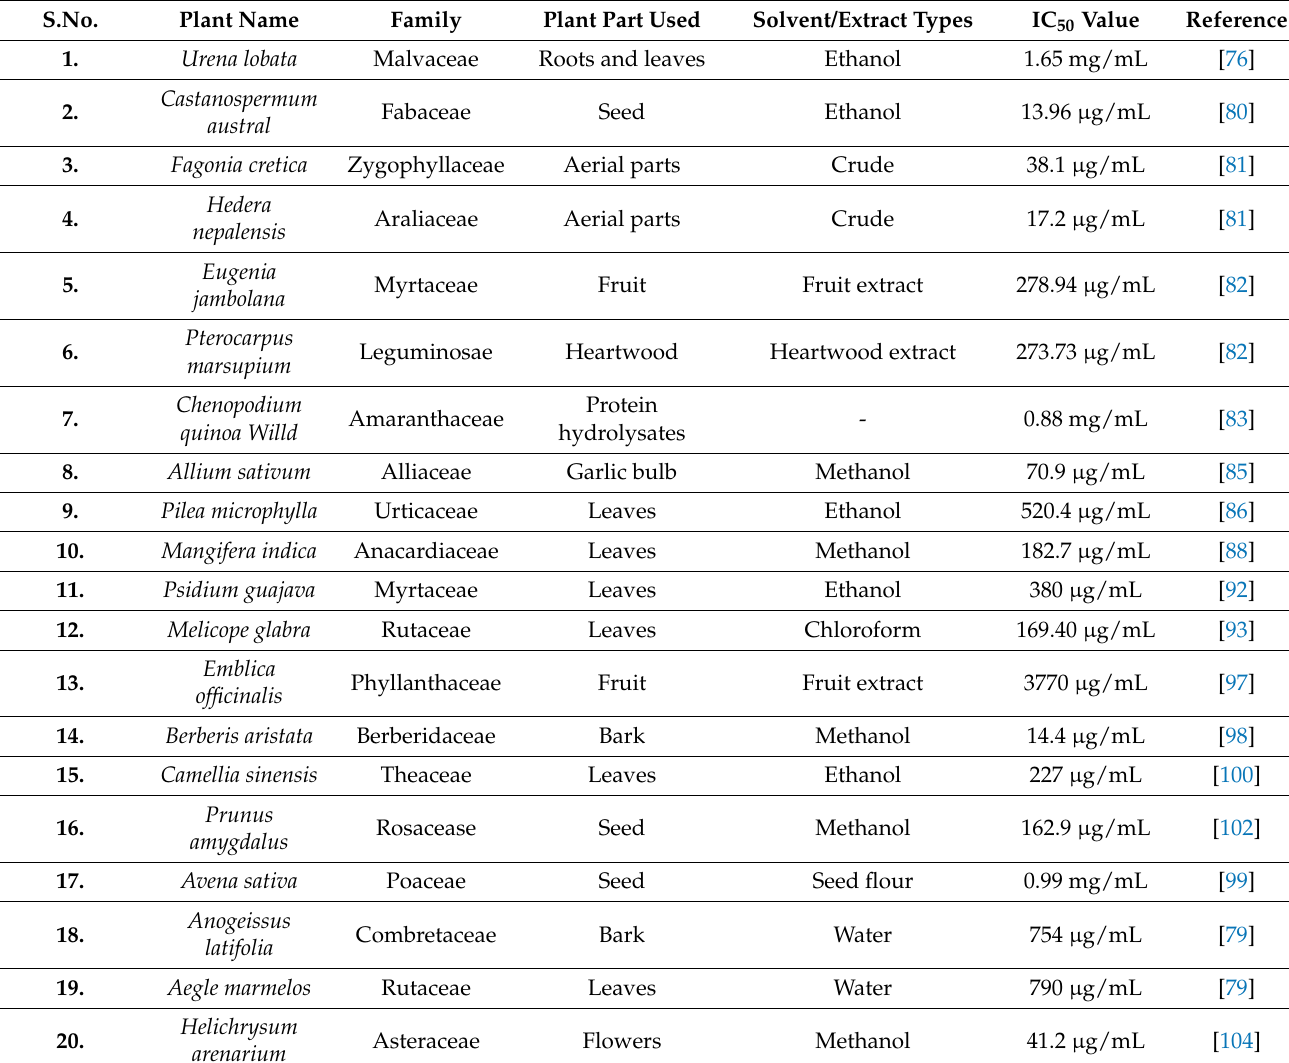
Table 2. Plants extracts that inhibit DPP-4 and their IC 50